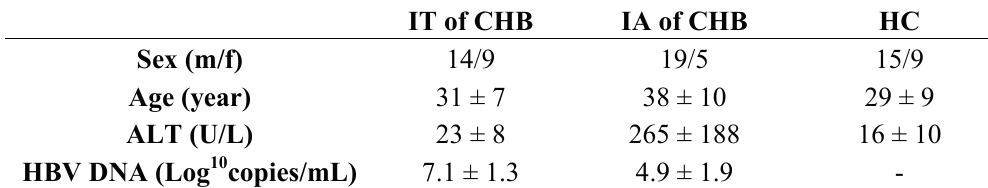
Table 3. Baseline data of group detected by